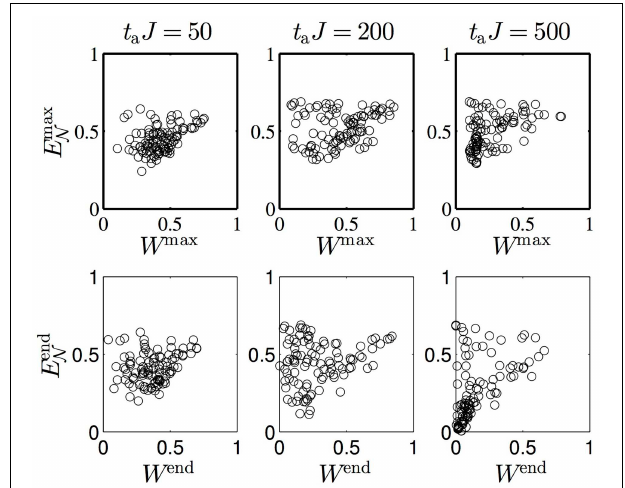
Frontiers in Physics |